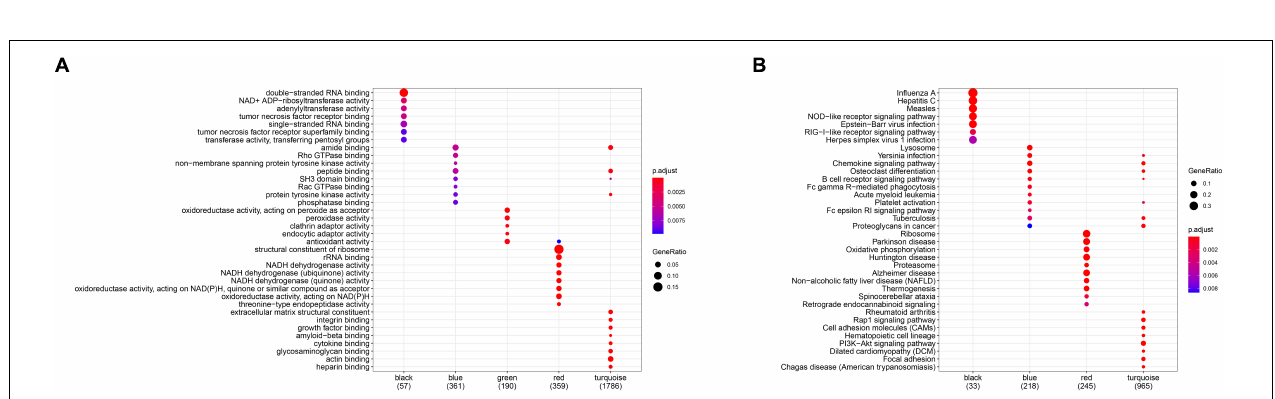
FIGURE 6 | Gene ontology (GO) (A) and Kyoto Encyclopedia of Genes and Genomes (KEGG) (B) enrichment analysis for all gene modules.